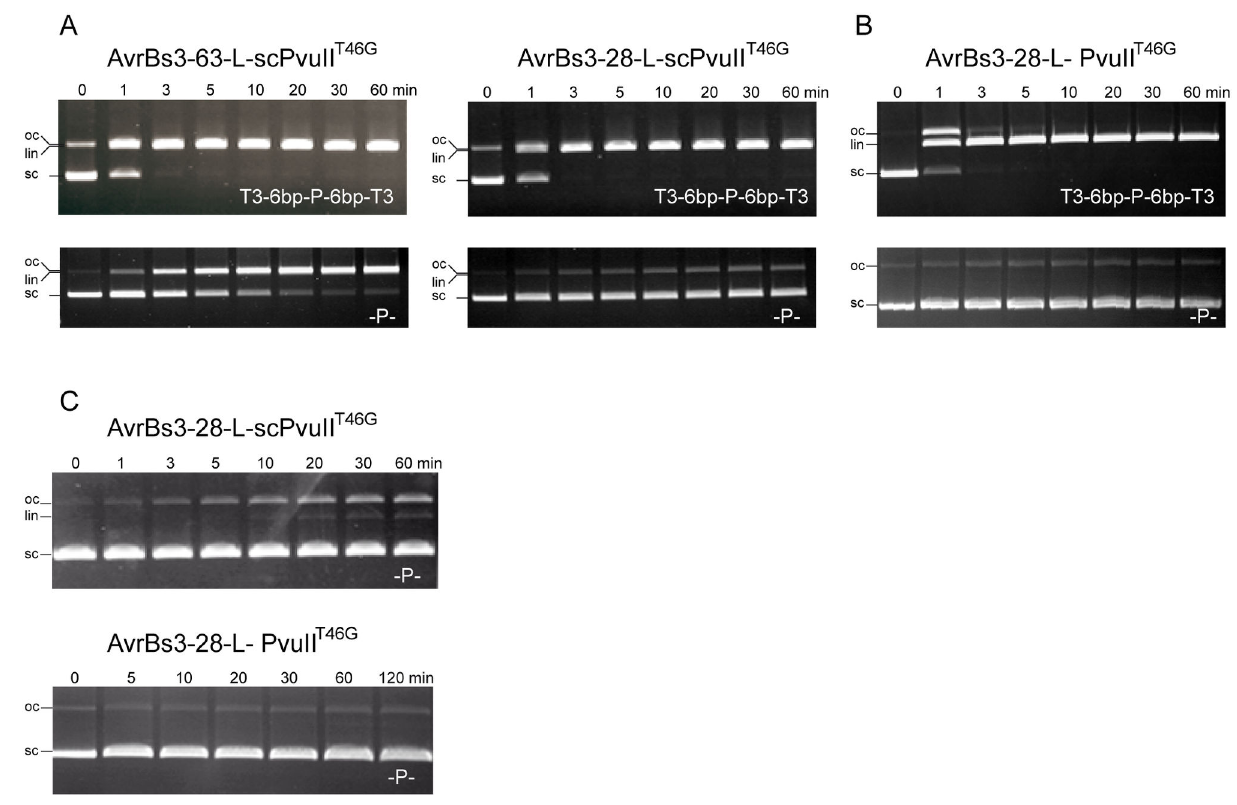
Figure 2. Analysis of the cleavage activity of AvrBs3-PvuII fusion proteins. ( A ) and ( B ) Comparison of the cleavage rates of selected AvrBs3-PvuII fusion proteins (as indicated) under low ionic strength: 76 mM (20 mM Tris-Ac, 50 mM K-Ac, 2 mM Mg-Ac, pH 7.5). In the top row the cleavage of the addressed substrate (T3-6bp-P-6bp-T3) is shown, in the bottom row that of the unaddressed substrate (-P-). All cleavage experiments were done with 8 nM DNA and 8 nM enzyme. ( C ) Comparison of the cleavage rates of an unaddressed substrate by selected AvrBs3-PvuII fusion proteins (as indicated) under physiological ionic strength: 143 mM (20 mM Tris-Ac, 120 mM K-Ac, 1 mM Mg-Ac, pH 7.5). The experiments were done with an excess of enzyme, the TALE-scPvuII fusion protein (top, 60 nM enzyme, 6 nM DNA) shows a higher cleavage activity with an unaddressed substrate (-P-) than the homodimeric TALE-PvuII T46G fusion protein (bottom, 80 nM enzyme, 8 nM DNA). See the appearance of nicked and linearized DNA with AvrBs3-28-L-scPvuII T46G . There is no nicking or cleavage detectable of the unaddressed substrate with AvrBs3-28-L-PvuII T46G . oc, open circle; lin, linearized; sc, supercoiled.